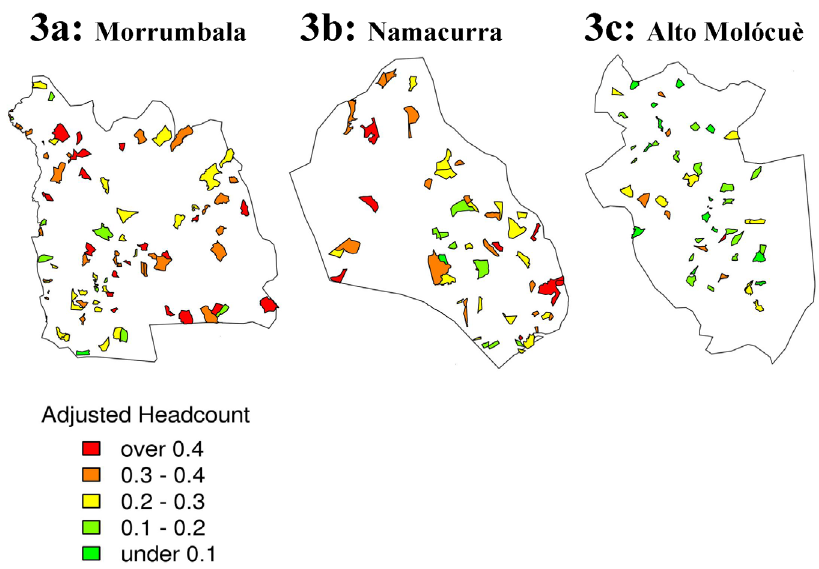
Figure 3. Enumeration Area Distribution in Three Focus District by Adjusted Headcount: Morrumbala, Namacurra and Alto Molo´cue`. *Enumeration area representations of poverty by adjusted headcount with green being less deprived and red.